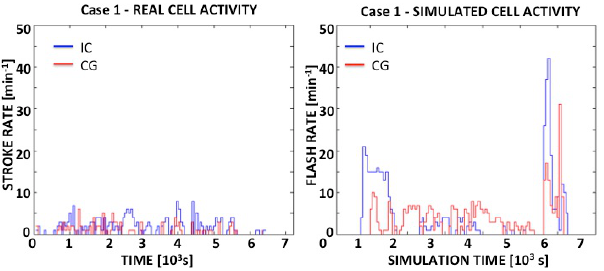
Fig. 10. Comparison between lightning measurements (left panel) and model results (right panel) for Case 1 (Munich, 29 July 2008). The left-panel histograms are built using the maximum number of IC and CG strokes that are registered in one-minute sampling inter- vals during a time frame of 7000s for all pixels in the area circled in Fig. 4. The right-panel histograms show the IC and CG flashes produced by the EMTM model in one-minute sampling intervals during the 7000s simulation time. In both panels, red line is for CG and blue line is for